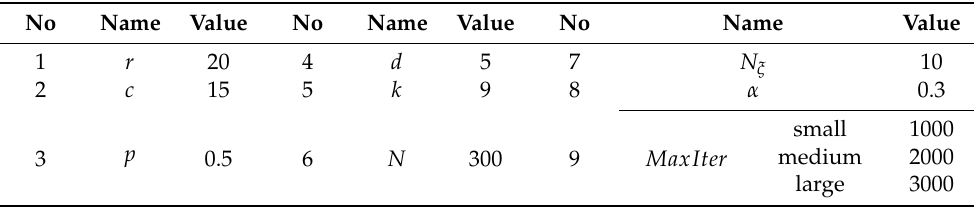
Table 2. The parameters of the IHKA and HKA.